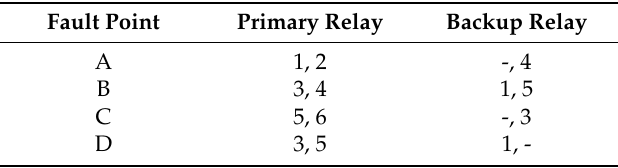
Table 5. Primary and backup relationships of the relays for Case 2.